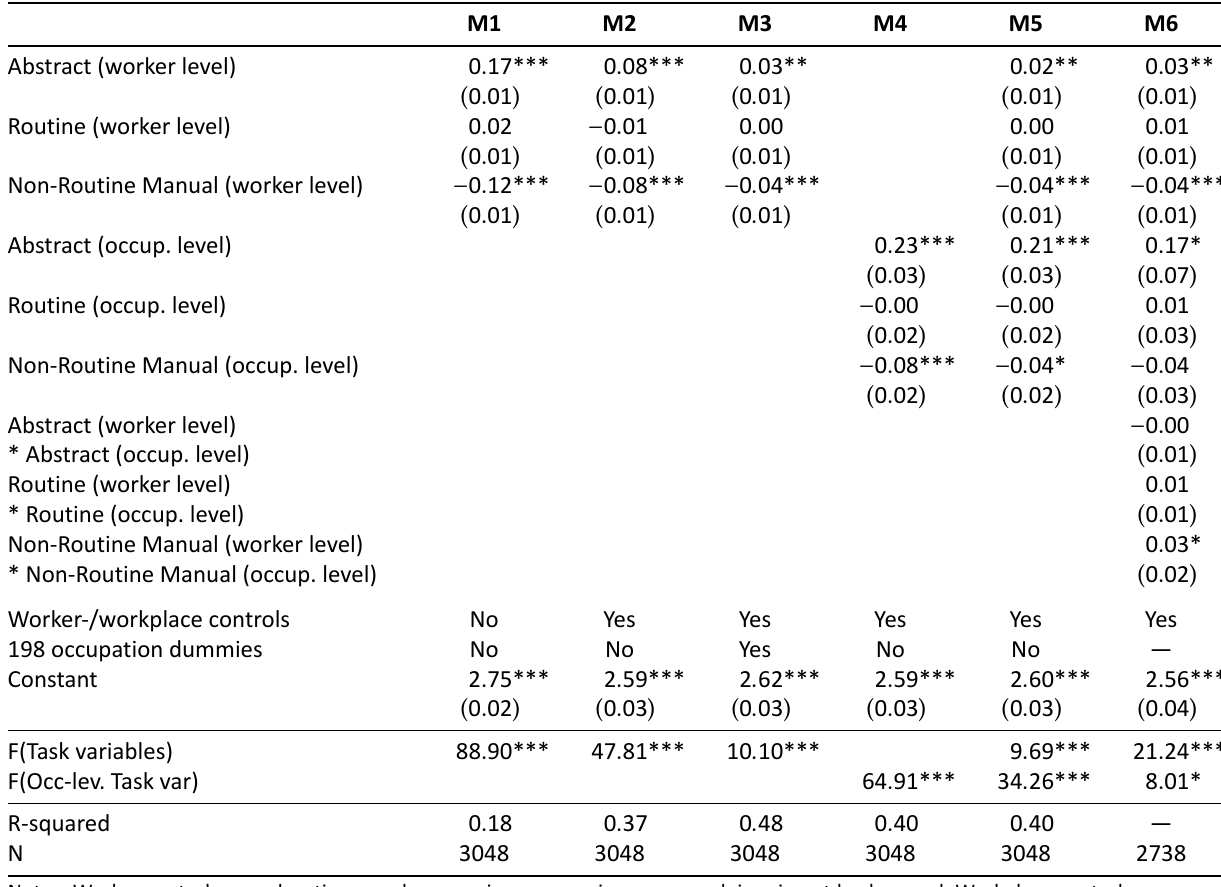
Table 5. OLS and Hausman-Taylor regressions of Log Hourly Wages on Task Scales. Source: BIBB/BAuA Employment Survey 2012 and Suppl. Task Survey to the Employment Survey